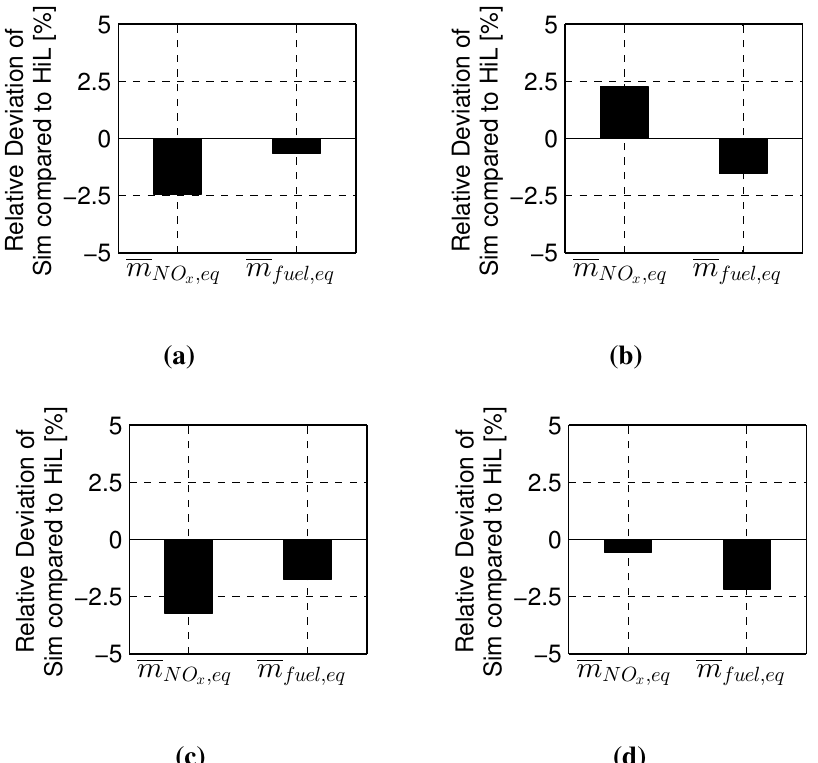
Comparison of the simulation results to the hardware-in-the-loop (HIL) experiments. The equivalent NO emissions ( m ) and the equivalent fuel x NO x , eq